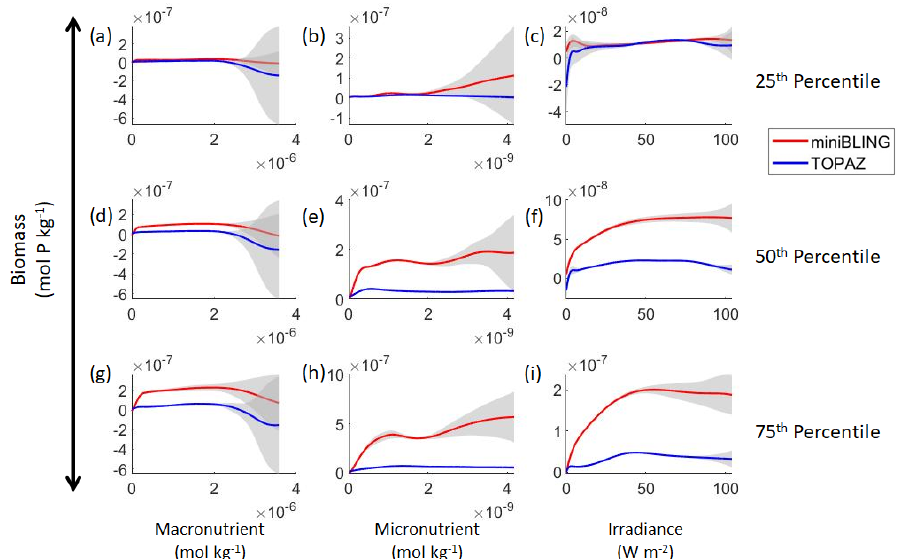
Figure 11. Sensitivity analysis plots for phytoplankton biomass for Case 3. Each line is the prediction for the NNE (i.e., the average prediction of 25 NNs) specific to each ESM, and the color of each line represents the ESM (miniBLING – red; TOPAZ – blue). The gray region around each line shows 1 standard deviation in the predictions of the individual NNs that make up each NNE (e.g., the gray region around the solid red curves shows the standard deviation in the predictions of the 25 NNs that make up that particular NNE). The rows correspond to the percentile value at which the other predictor variables were held constant (e.g., panel a varies the macronutrient across its min–max range and holds the micronutrient and irradiance at their respective 25th percentile values). Columns show the x -axis variables as they vary between their min–max range. The y axis in all panels is the biomass concentration. Note that the biomass scale changes with each panel.